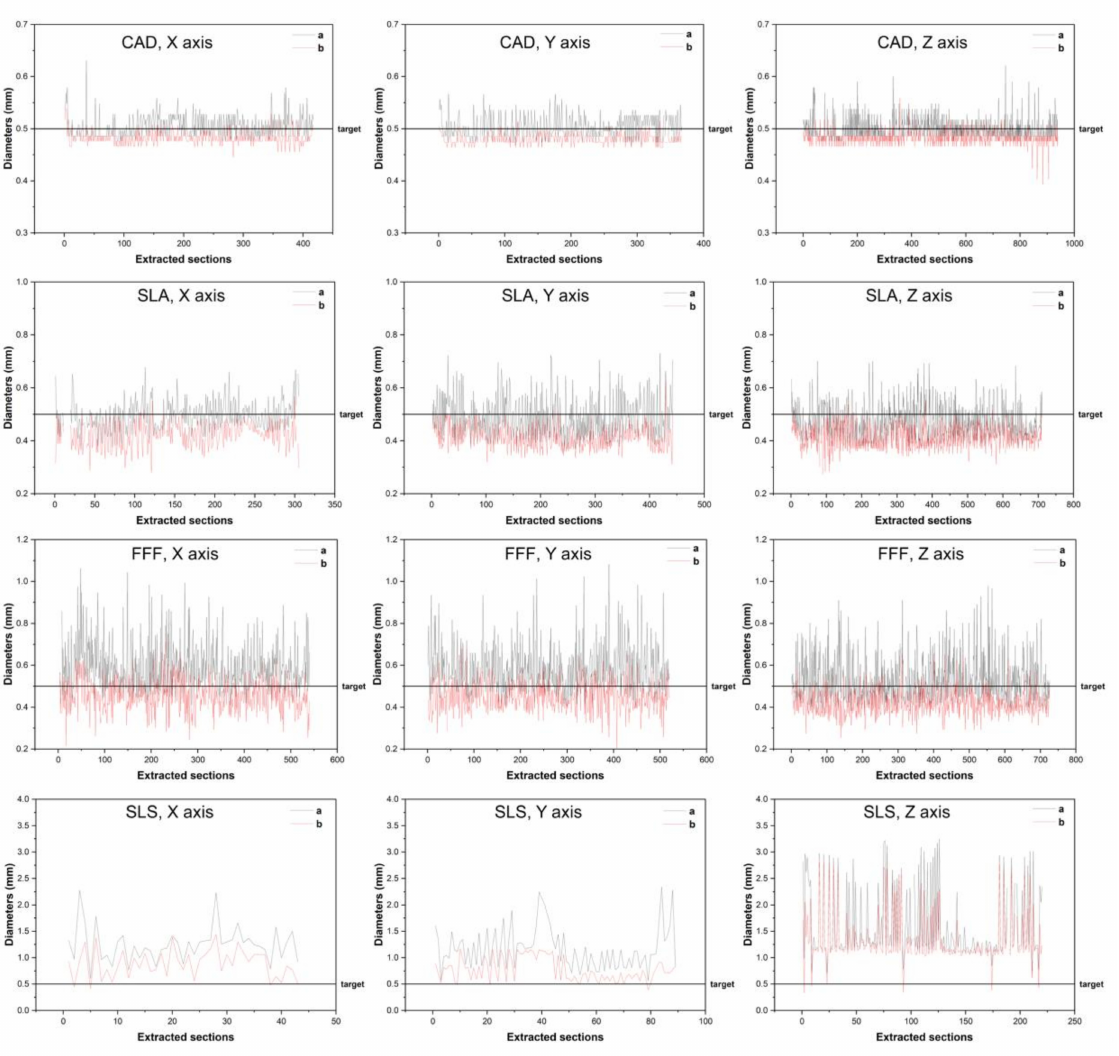
Figure 11. Representation of the diameters a and b, sample 05 for CAD model and the three